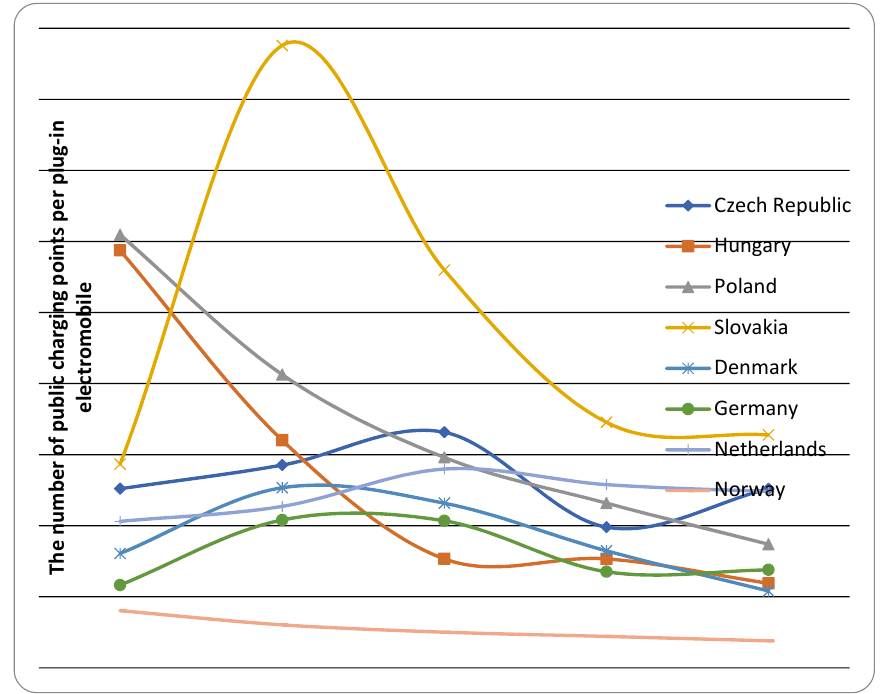
Figure 8. The development of the parameter N e (the number of public charging points per plug-in electromobile).